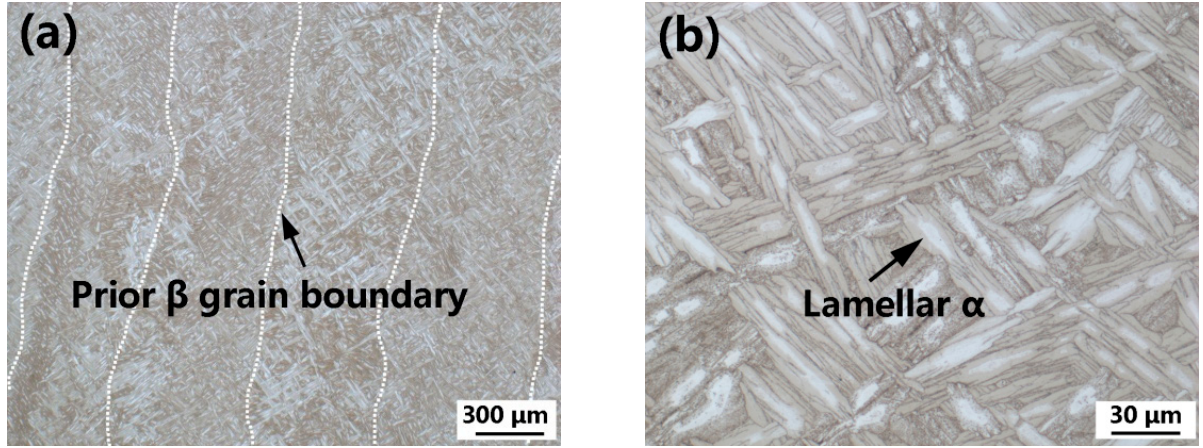
Figure 8. Cross-sectional macrostructure ( a ) and microstructure ( b ) of the post-deposition STA Ti60 alloy. The prior β grain boundaries in ( a ) were traced in white dots.